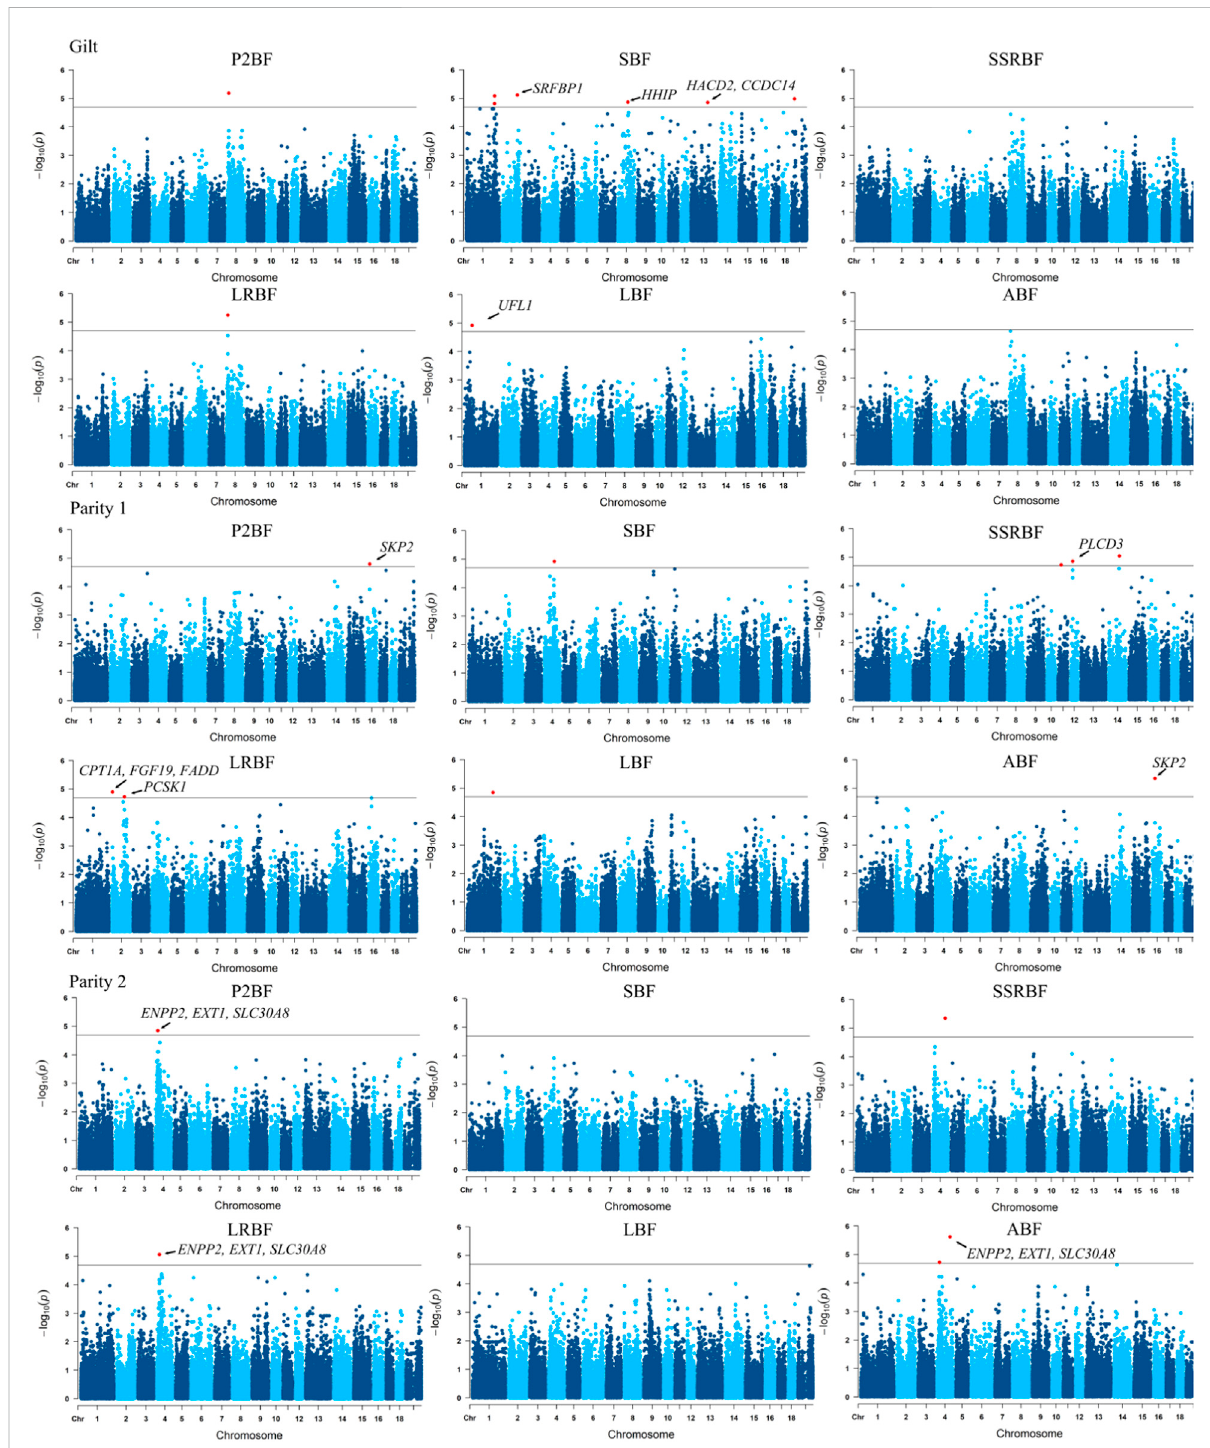
FIGURE 6 Manhattanplotofgenome-wideassociationanalysisofP2-backfat,shoulderbackfat,sixthandseventhribsbackfat,lastribbackfat,lumbarjoint backfat and average backfat at different parity. The annotated genes represent the relevant candidate